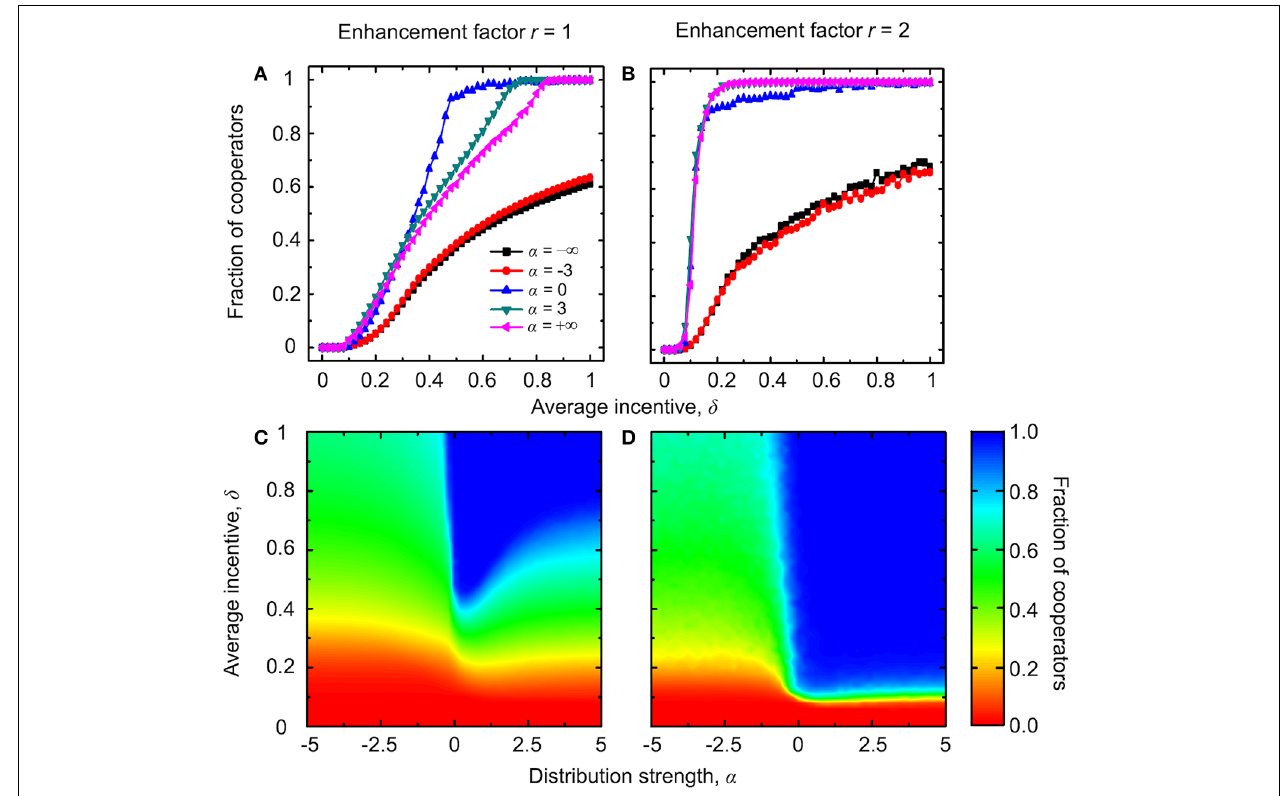
FIGURE 1 | Evolution of cooperation with institutional rewarding and absolute payoffs. Top row depicts the stationary fraction of cooperators as a functionoftheaverageamountofavailableincentives δ fordifferentvaluesofthe